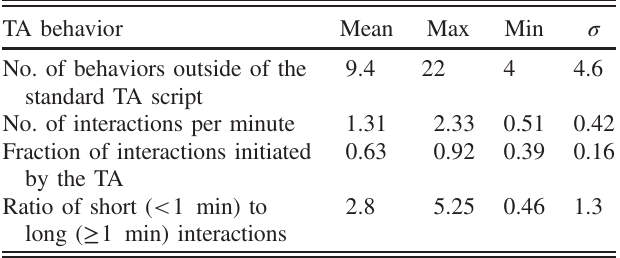
TABLE II. TA behavior data descriptives.